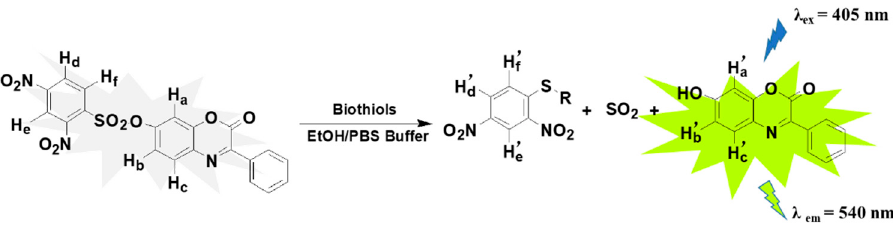
Scheme 2. Schematic sensing mechanism of PBD toward